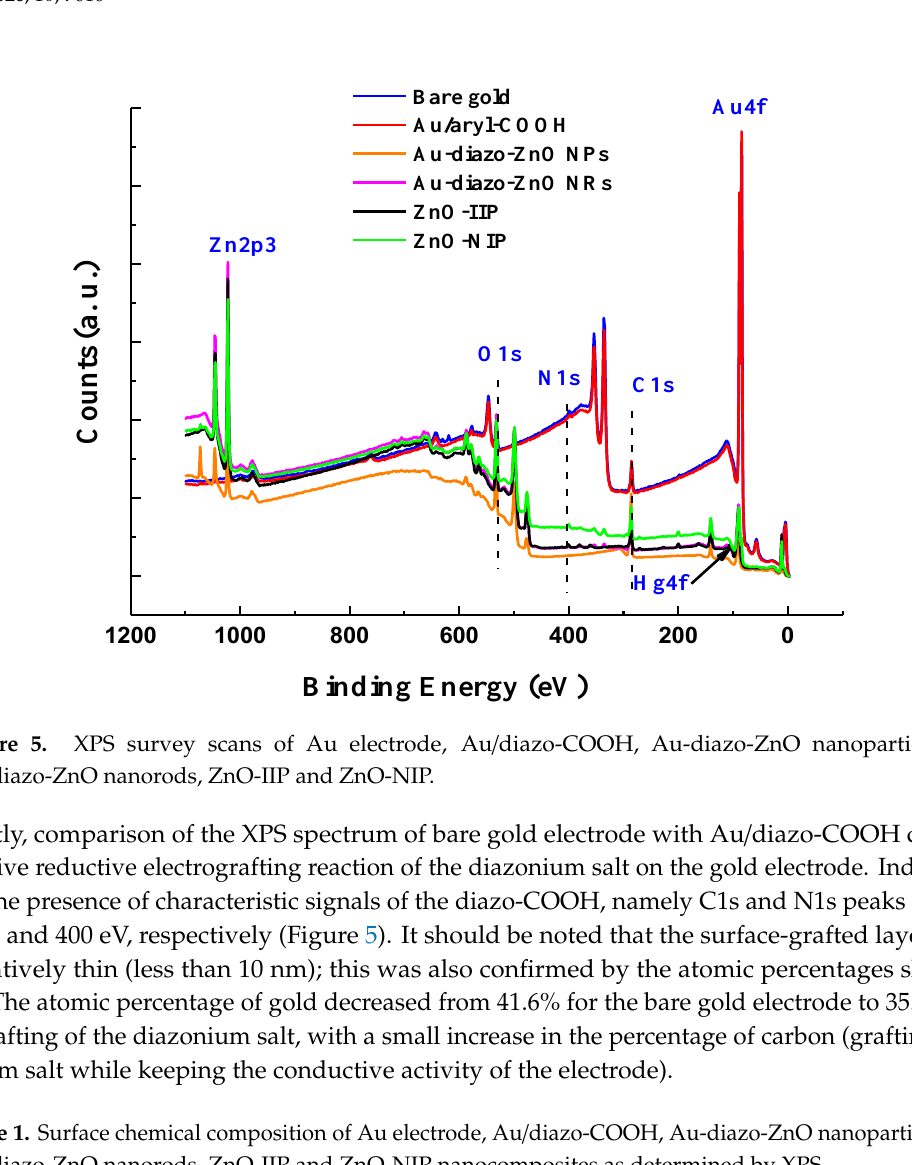
Table 1. Surface chemical composition of Au electrode, Au / diazo-COOH, Au-diazo-ZnO nanoparticles, Au-diazo-ZnO nanorods, ZnO-IIP and ZnO-NIP nanocomposites as determined by XPS.